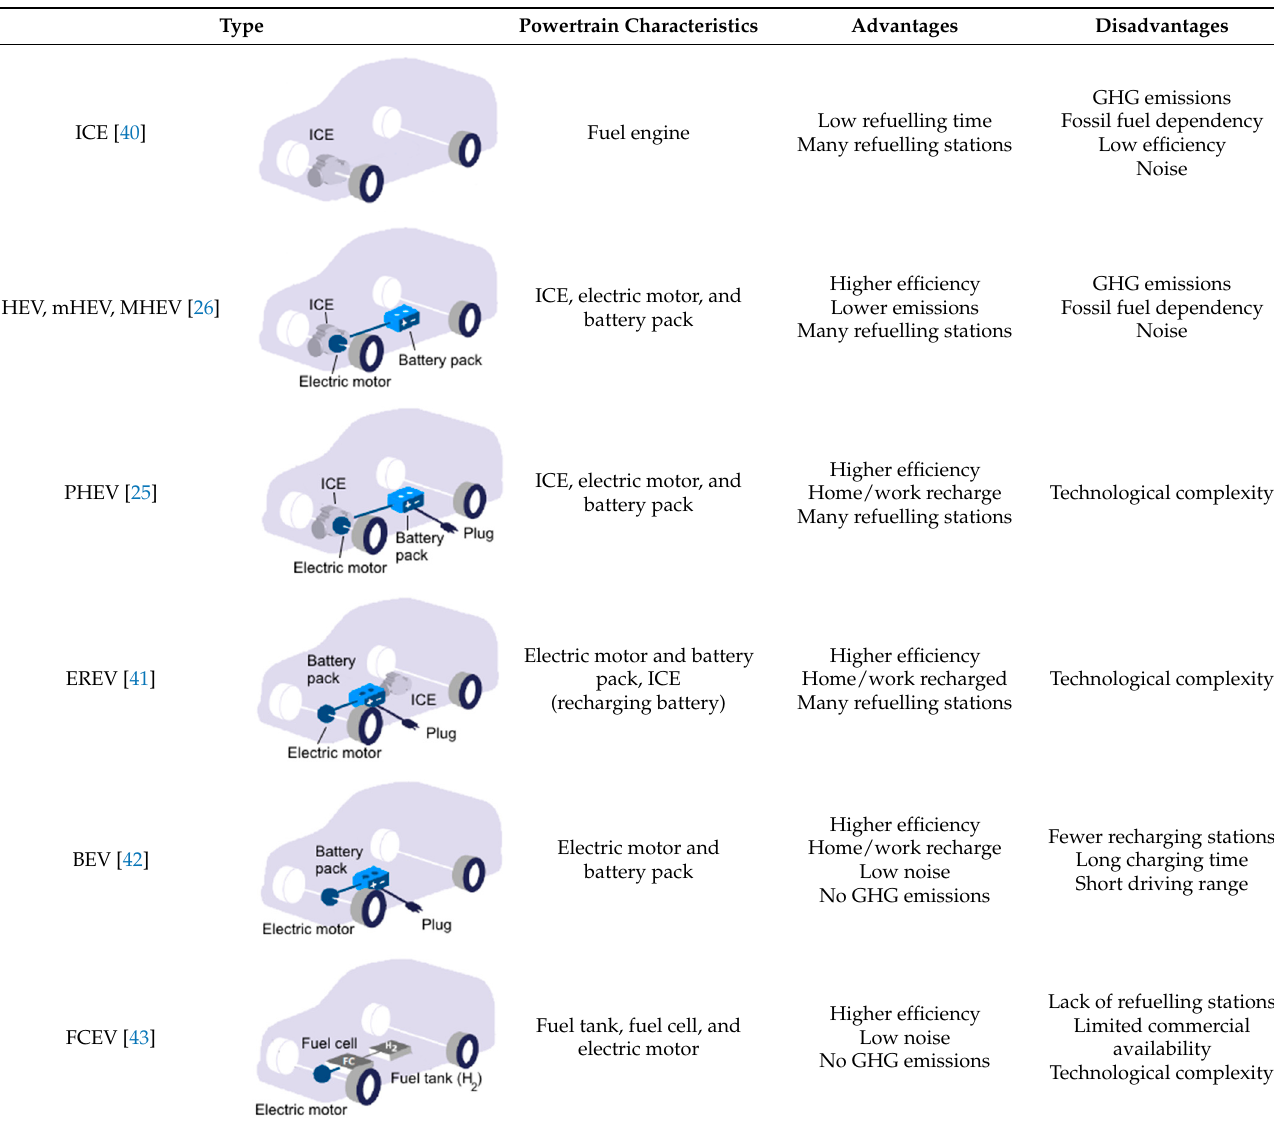
Table 1. Typologies and characteristics of vehicles.